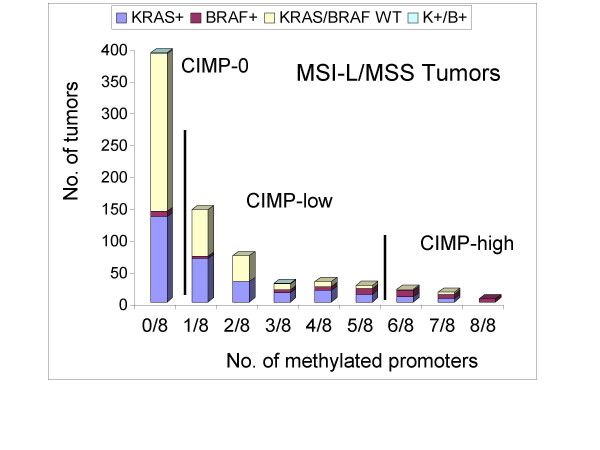
Distribution of MSI-L/MSS colorectal cancers according to the number of methylated promoters. The X and Y axes indicate the number of methylated promoters and the number of tumors, respectively. Based on the KRAS and BRAF mutation rates, CIMP-high is defined as the presence of ≥ 6/8 methylated promoters. Also note that CIMP-0 tumors with 0/8 methylated promoters are more likely to have both wild-type KRAS and BRAF, compared to CIMP-low tumors with 1/8 to 5/8 methylated promoters. Abbreviations: BRAF+, BRAF-mutated KRAS wild-type; KRAS+, KRAS-mutated BRAF wild-type; K+/B+, KRAS-mutated BRAF-mutated; KRAS/BRAF WT, both wild-type KRAS and BRAF; MSI-L, microsatellite instability-low; MSS, microsatellite stable.